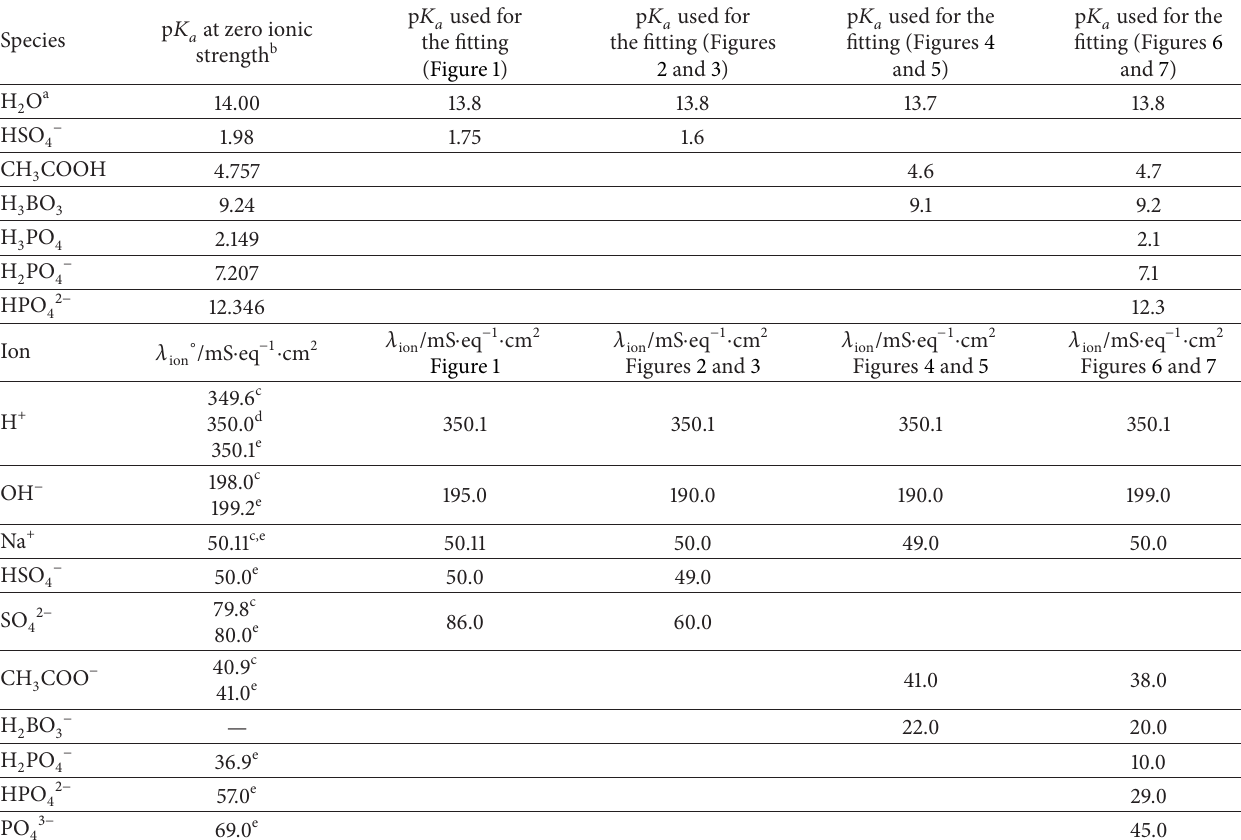
Table 1: Comparison of the p 𝐾 𝑎 and the limiting equivalent conductivities values from different sources, at 𝑇 = 25 ∘ C and zero ionic strength, with the p 𝐾 𝑎 and the equivalent conductivities values used to construct the plots in Figures 1–7 with a robust model to perform the estimation. p 𝐾 𝑎 used for p 𝐾 𝑎 used for p 𝐾 𝑎 used for the p 𝐾 𝑎 used for the p 𝐾 𝑎 at zero ionic Species the fitting the fitting (Figures fitting (Figures 4 fitting (Figures 6 strength b (Figure 1) 2 and 3) and 5) and 7) H O a 2